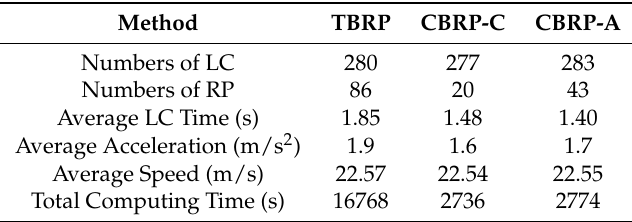
Table 3. Result of Random Traffic Test